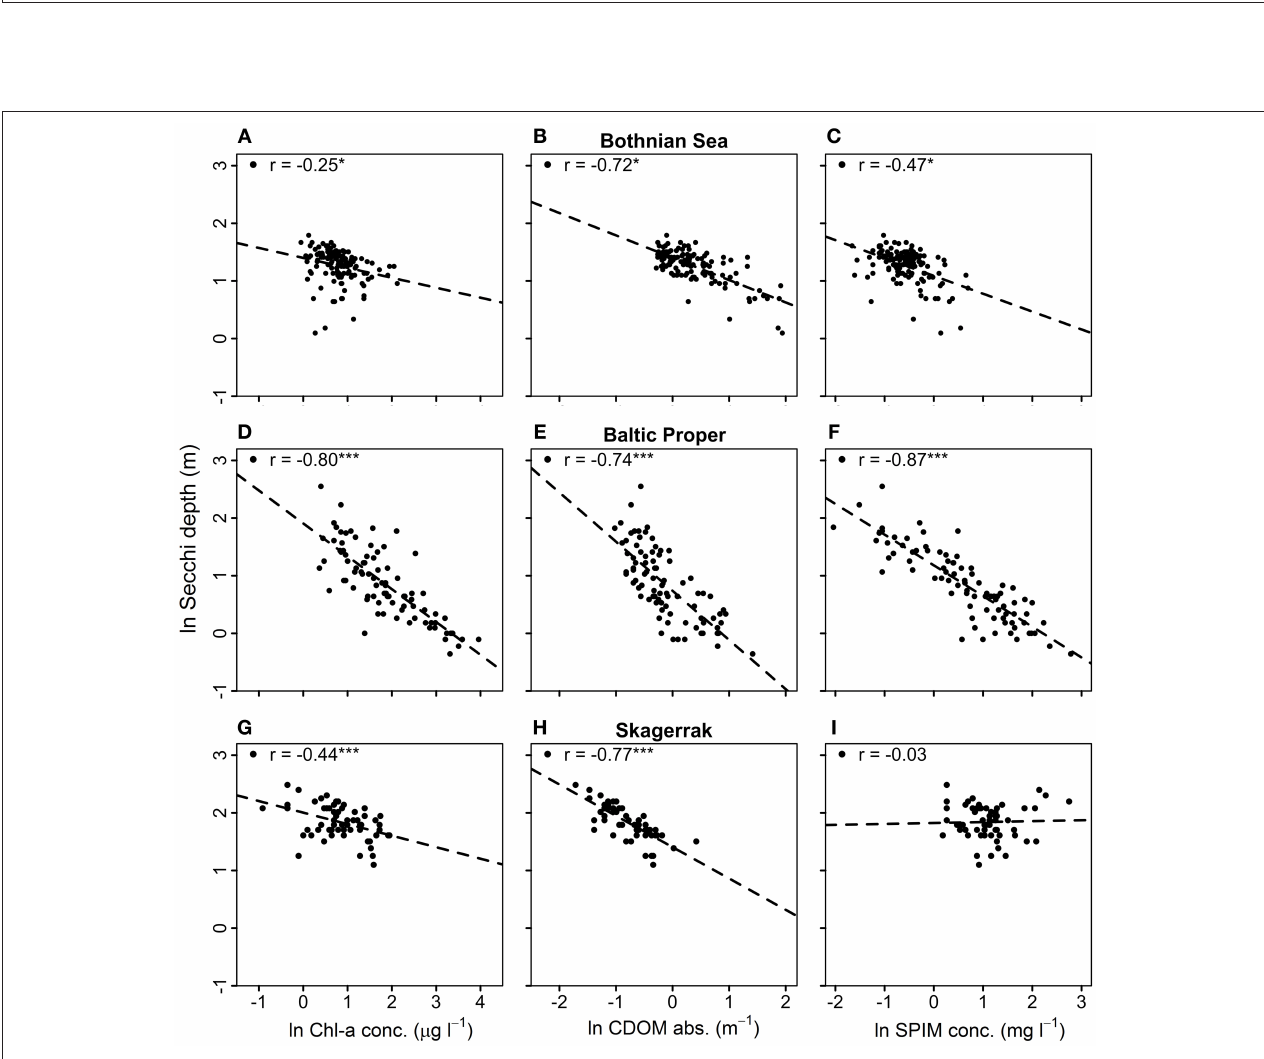
FIGURE 3 | Correlation plots between Secchi depth, Z SD (m) and the predicting parameters; Chl-a [ µ g l − 1 ] (left), CDOM (m − 1 ) (middle), and SPIM [g m − 3 ] (right). Graphs (A–C) show data from the Bothnian Sea (BS), (D–F) from the Baltic Proper (BP) and (G–I) from the Skagerrak (SK). The Pearson correlation coefficient, r, is shown for each data-set, where *, *** denotes significant correlations at 0.01 and 0.0001 levels and no star indicates non-significance. All data have been natural log-transformed.